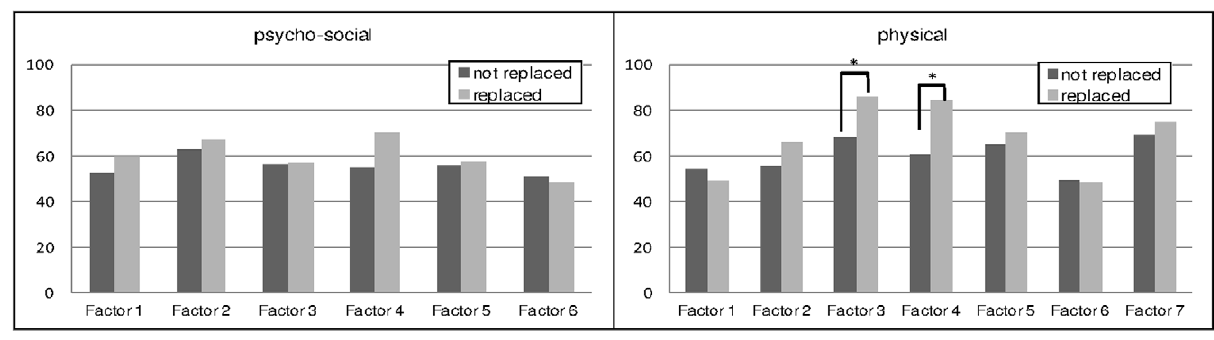
Figure 1. Sub-domain scores by clinical variables that might affect the scores. Note 1: All p values were calculated by t-test, and asterisks indicate statistically significant differences (P , 0.05) between groups. Note 2: Sub-domain names are as follows: Psycho-social domain (Factor 1: Depressed mood, Factor 2: Limitation in social activities, Factor 3: Vigor, Factor 4: Sleep, Factor 5: Anxiety about treatment, Factor 6: Interpersonal relationships) Physical domain (Factor 1: Control of body temperature, Factor 2: Physical strength, Factor 3: Immunity, digestive tract, and musculoskeletal system, Factor 4: Urination, Factor 5: Skin condition and visual acuity, Factor 6: Body weight, Factor 7: Sexual function).